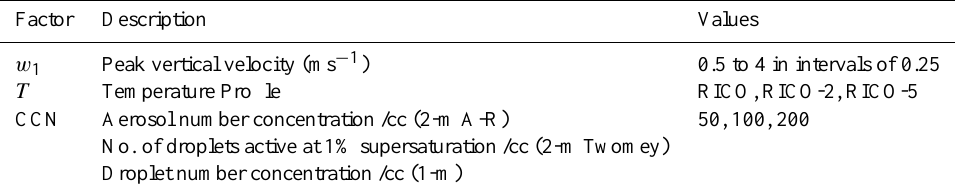
Table 3. Summary of the factorial design for the bulk microphysics.